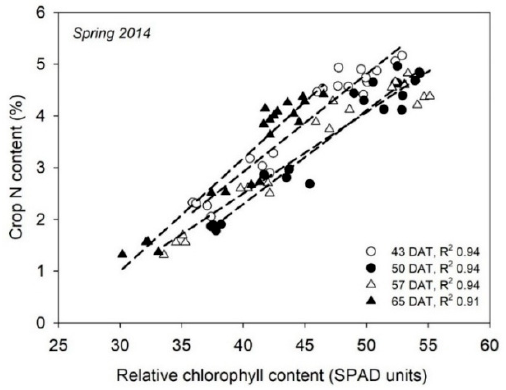
Figure 2. Relationships of SPAD units to crop N content from a greenhouse-grown cucumber crop carried out in southeast Spain. DAT is days after transplanting and R 2 is the coefficient of determination.